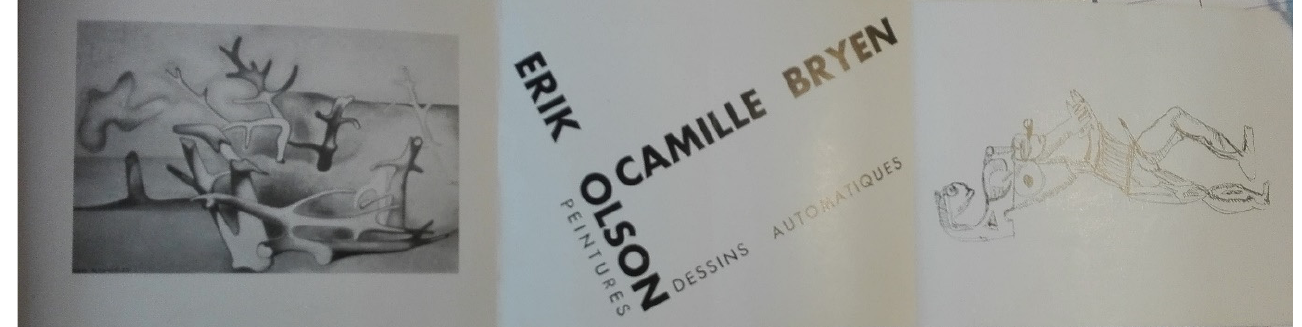
Figure 1. Invitation for the opening of the exhibition Eric Olson: Peintures/Camille Bryen: Dessins automatiques , 18 June–10 July 1935. Bryen Fund, Bibliothèque Kandinsky/Musée National d’Art Moderne/ Centre Georges Pompidou, Paris. Copyright: ADAGP.